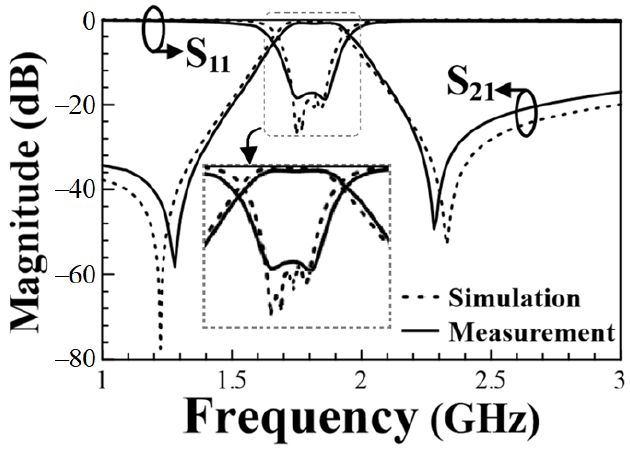
Figure 10. The measured and simulated frequency responses for the proposed sample HMSICR BPF.